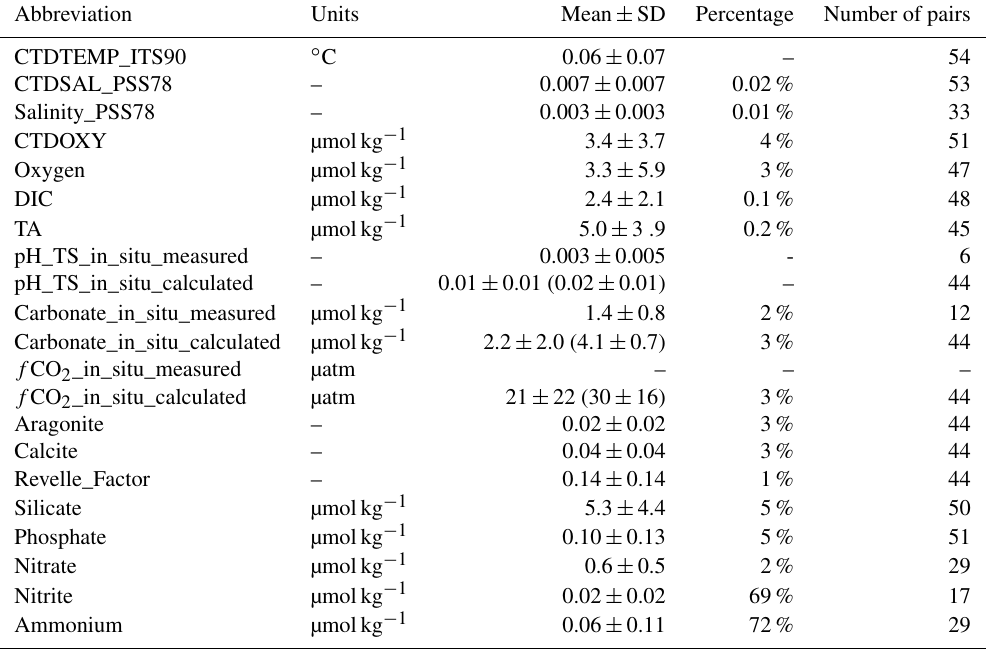
Table 7. Uncertainties of some variables based on an analysis that groups deep-water stations ( > 1000m sampling depth) within a 10km radius and 200m depth difference. SD is short for standard deviation. Numbers in parentheses are expected errors based on propagating uncertainties in carbonate system calculations using DIC, TA, and others as input parameters with the CO2SYS companion errors.m program. Refer to Table 1 for their full names and respective units.